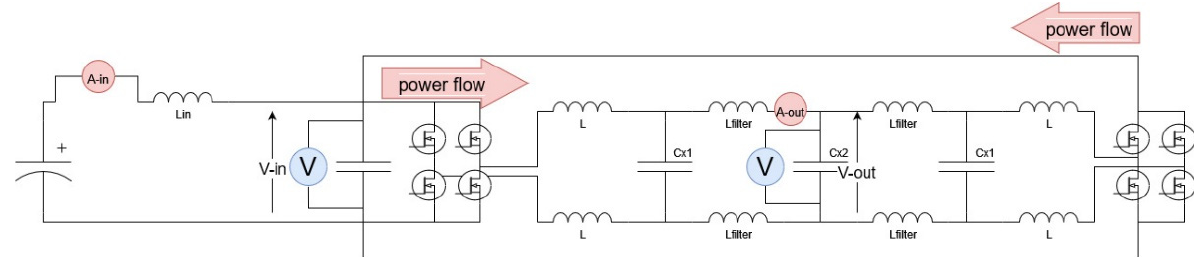
Figure 25. Schematic of the opposition method to characterize converter losses.